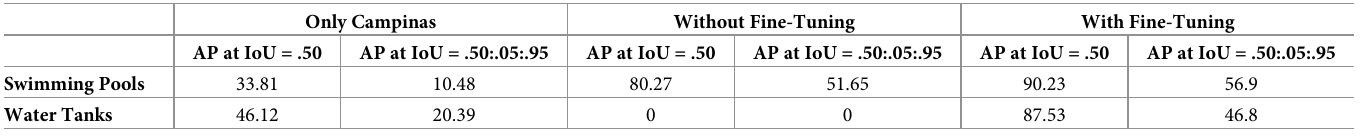
Table 2. Metrics for water tanks and swimming